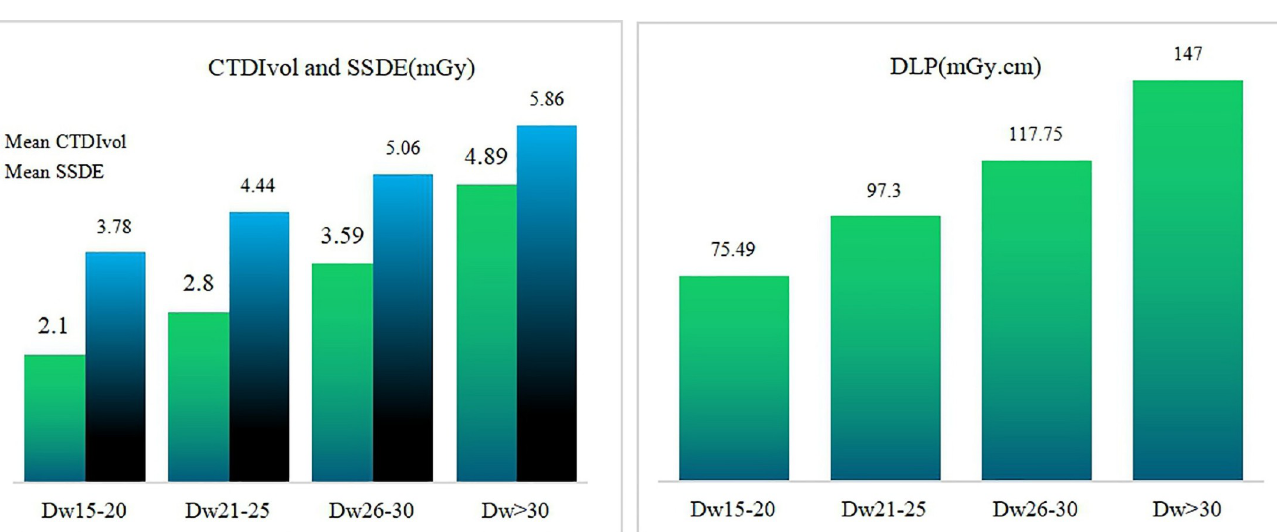
PLOS ONE | https://doi.org/10.1371/journal.pone.0257294 September 13,